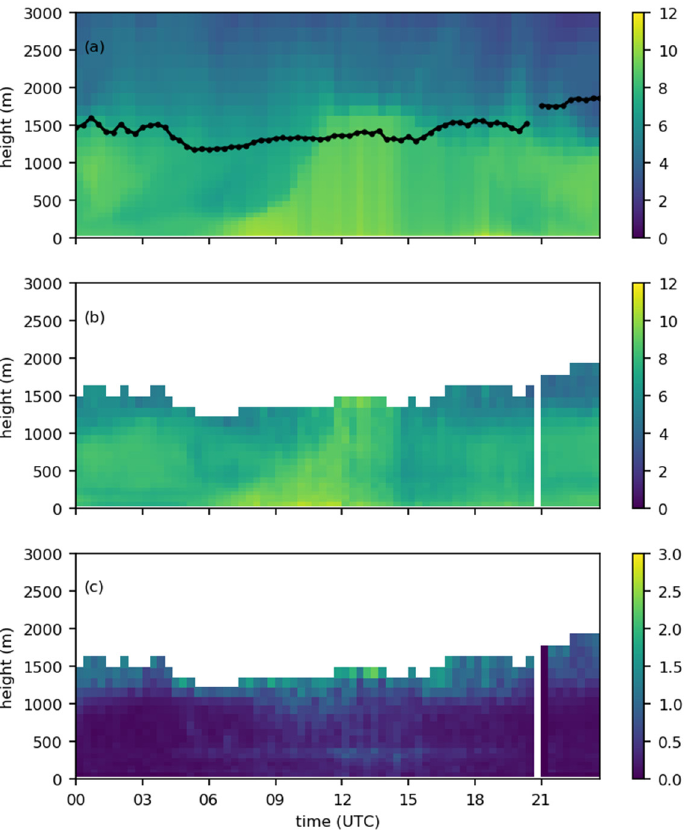
Figure 11. Water vapour mixing ratio, 24 June 2020: ( a ) UKV model background; ( b ) BB-DIAL measurement thinned at UKV resolution (time and height); ( c ) BB-DIAL uncertainty, all values are g/kg